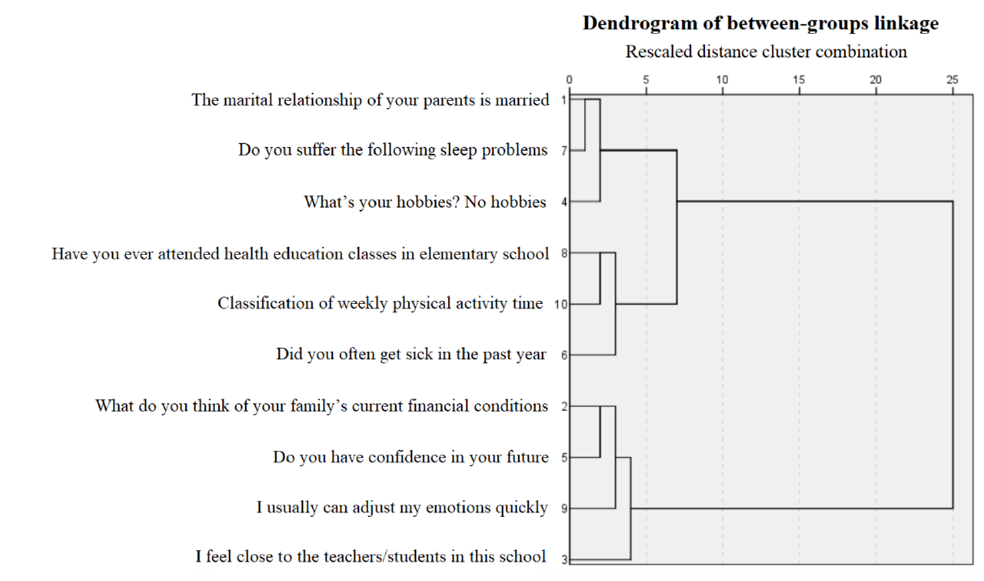
Fig. 1 Cluster analysis of factors affecting adolescent